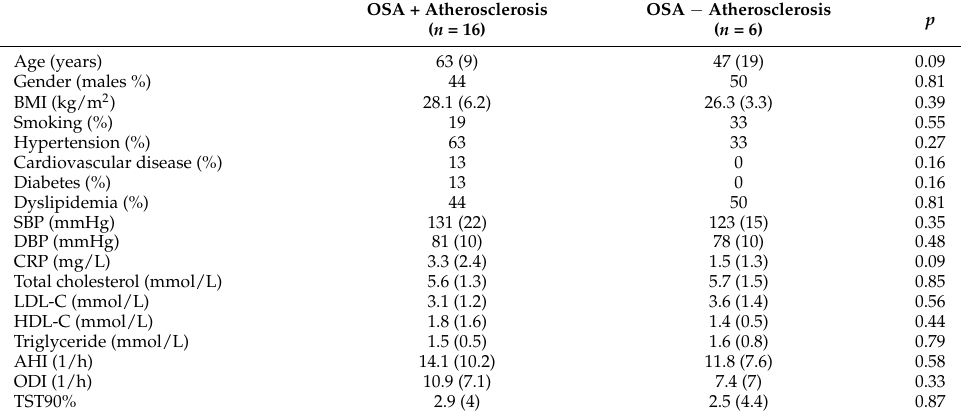
Table 1. Descriptive analysis in the two groups.